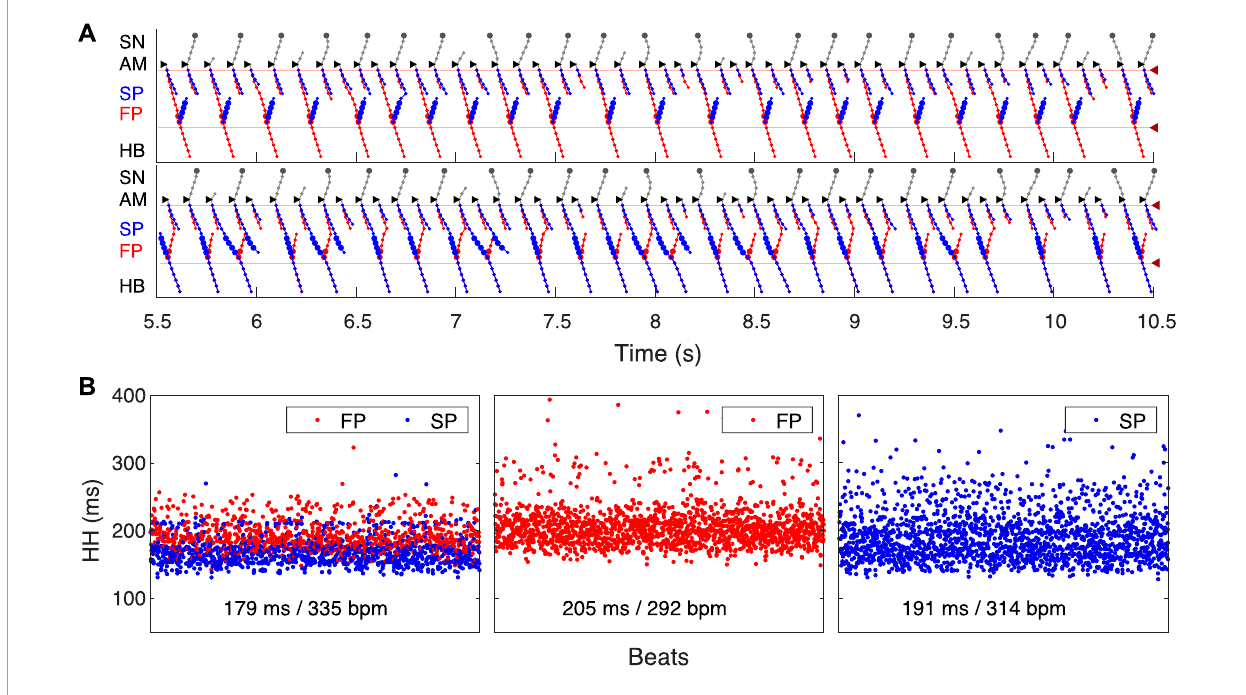
FIGURE 12 Impact of ablation on AVN filtering function. (A) Laddergrams of atrial fibrillation stimulated by the same random impulse sequence as in Figure 11 after SP ablation (top panel) and after FP ablation (bottom panel). (B) Distribution of consecutive HH intervals for intact AVN and after ablations. Random atrial pacing in the 75–125 ms range was applied for 350 s. Control case (left panel), after SP ablation (middle panel), and after FP ablation (right panel). Mean HH intervals and HB rates for each case are shown at the